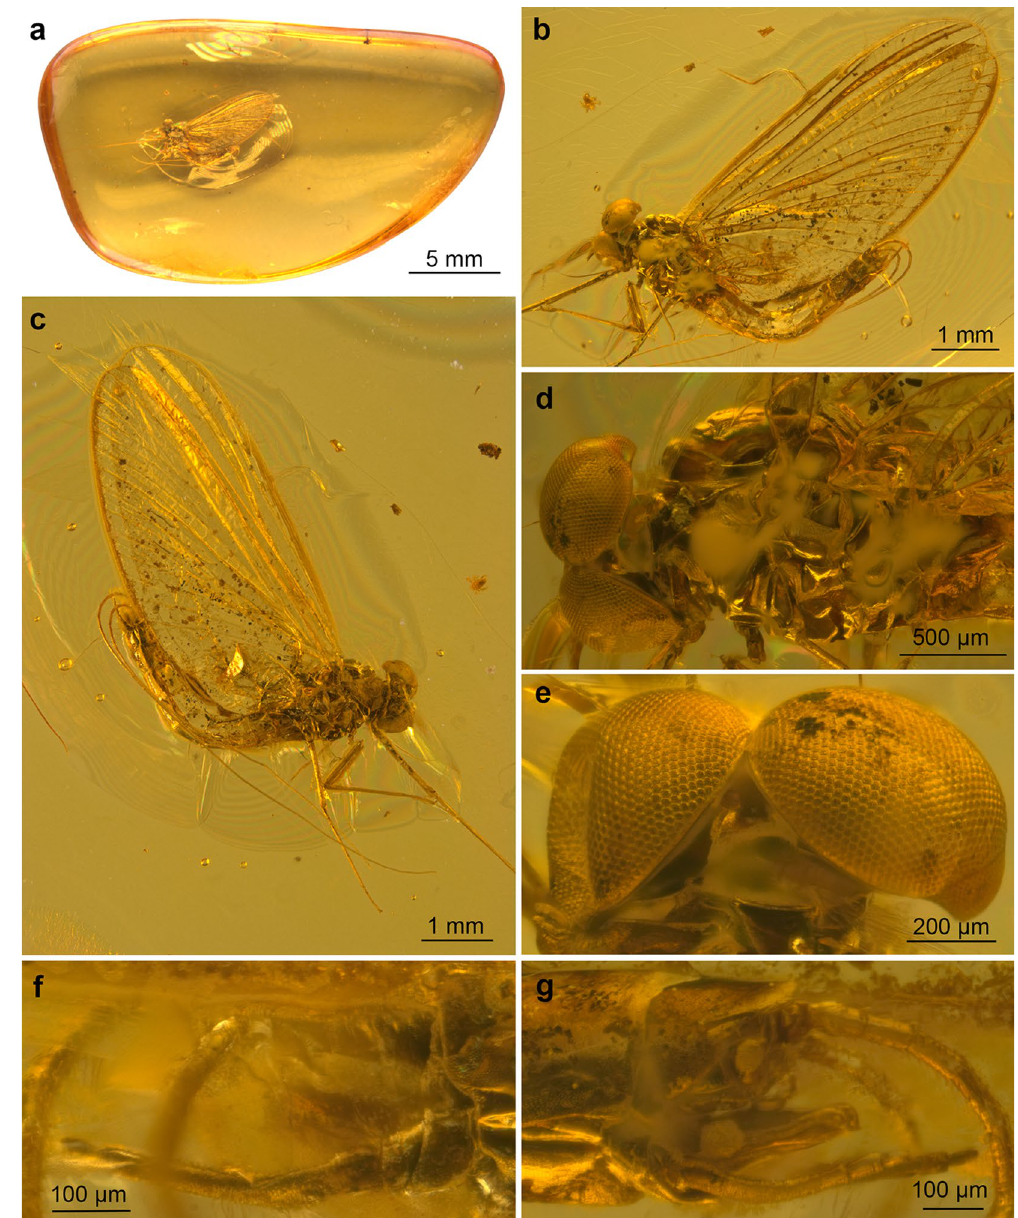
Figure 1. Calliarcys antiquus sp. nov., holotype, male imago; Eocene Baltic amber; BB 2515 [SMNS coll.]; ( a ) entire piece of amber with embedded holotype in lateral view; ( b ) enlarged total lateral view from left side; ( c ) total lateral view from right side; ( d ) head and thorax in dorsolateral view from left side; ( e ) details of compound eyes in dorsal view; ( f ) genitalia in right lateral view; ( g ) genitalia in left lateral